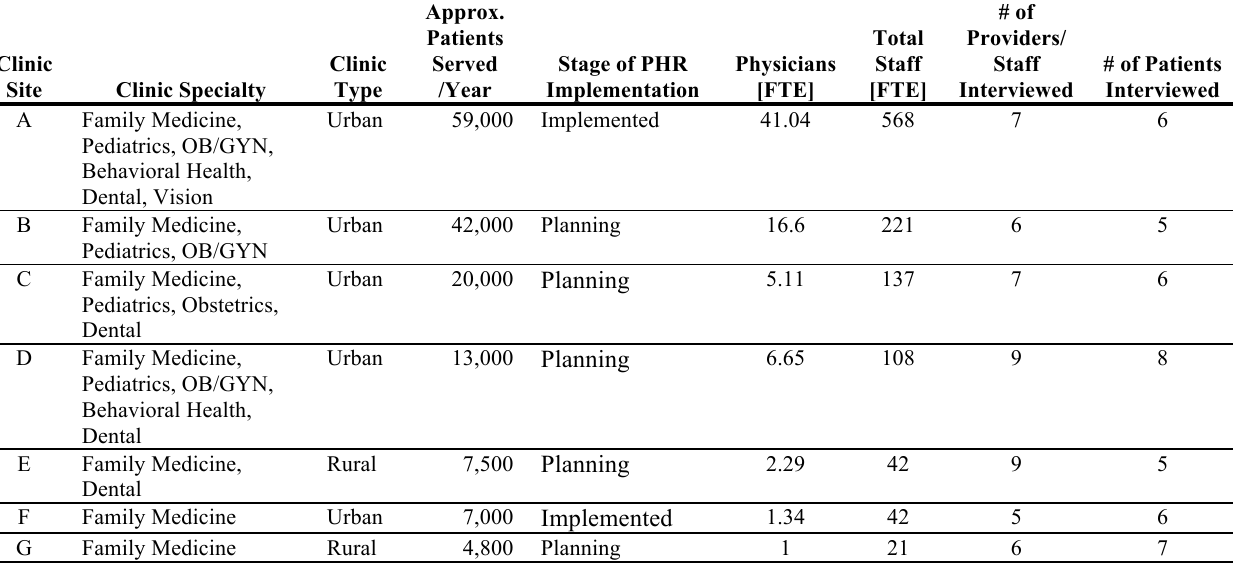
Table 1. Summary Characteristics of Participating CHC